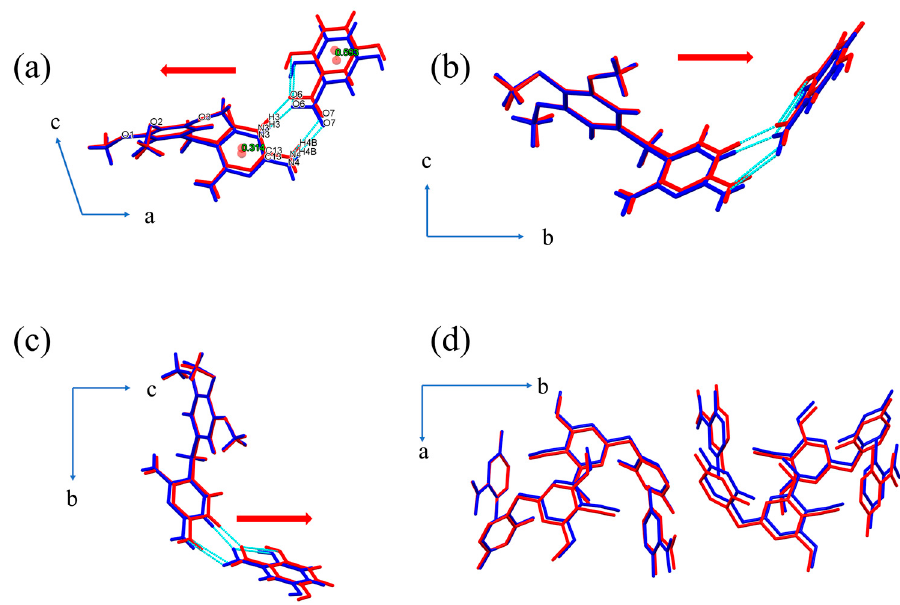
Figure 8. Conformations of the asymmetric unit at high and low temperature along different directions ( a – c ); ( d ) comparison of molecular packing at high and low temperature. (Blue is for low temperature and red is for high temperature).